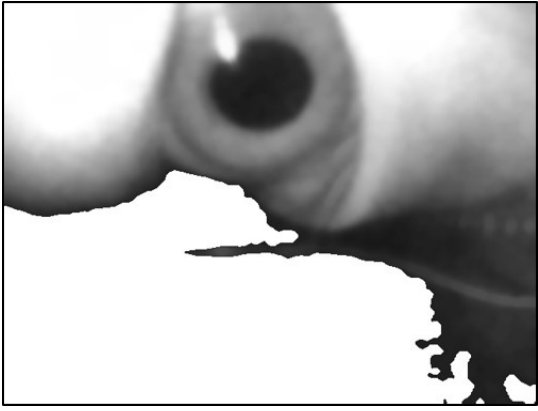
Figure 22. Superimposed mask image.